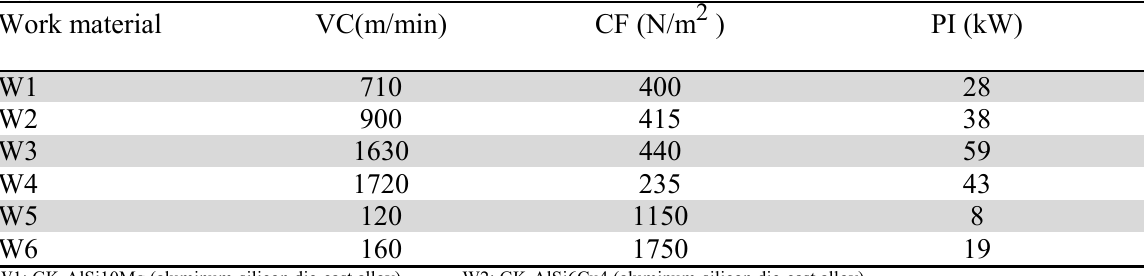
Objective data of the alternative alloys